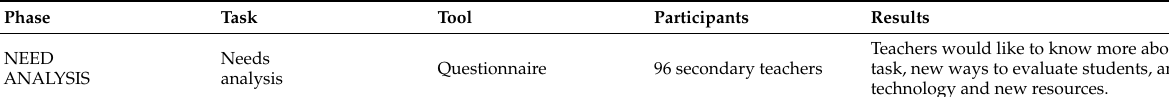
Table 2. Research phases and description of